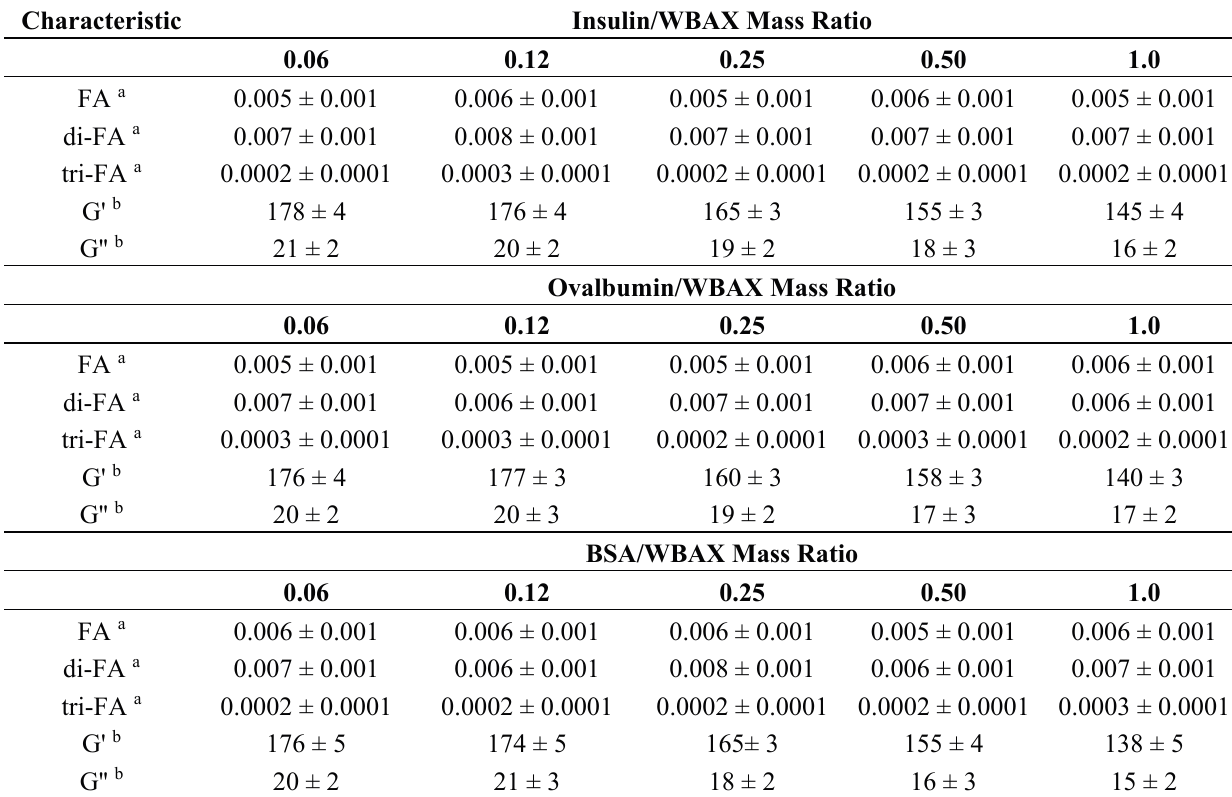
Table 2. Characteristics of protein/WBAX mixtures after 6 h